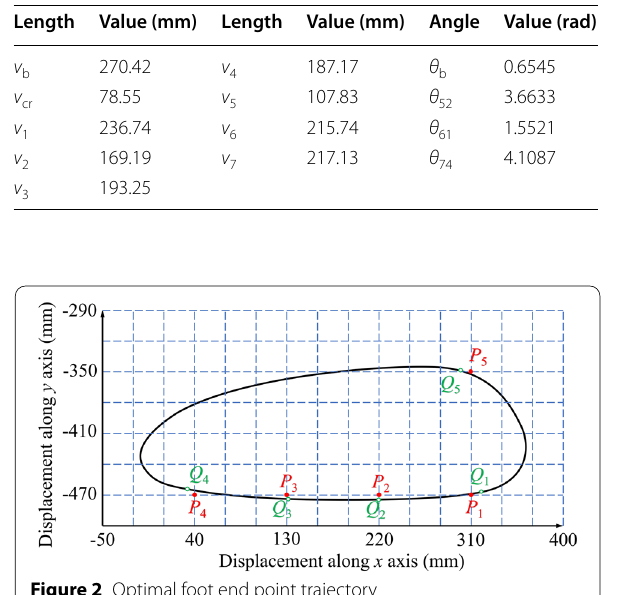
Table 2 Link geometry parameters